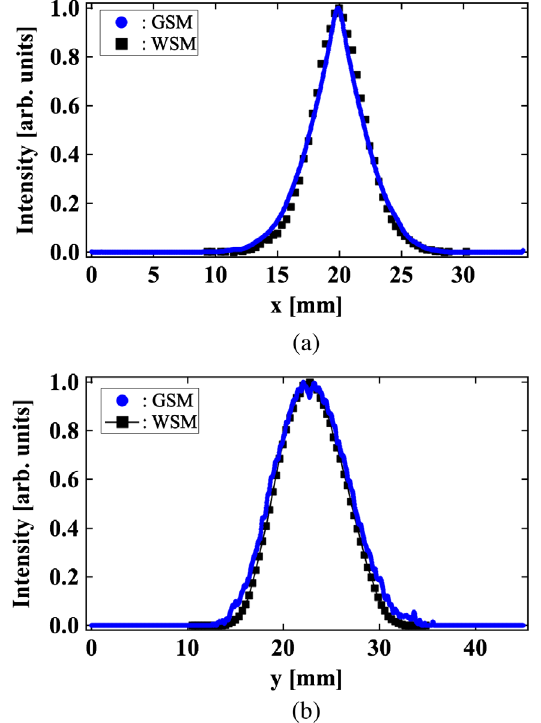
FIG. 14. The beam profiles obtained by the gas sheet monitor (GSM) are compared with those obtained by the wire scanner monitor (WSM): (a) the projected x profiles and (b) the projected y profiles.